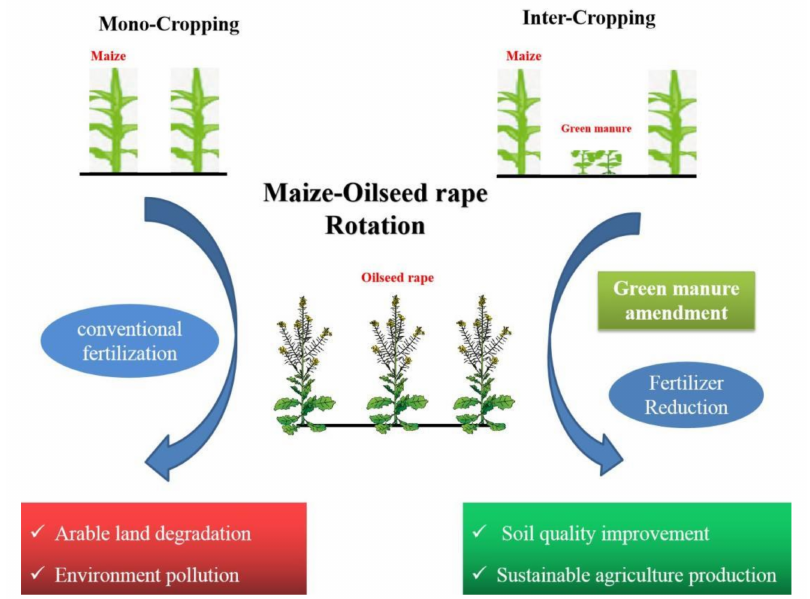
Figure 1. Green manure amendment in maize–oilseed rape